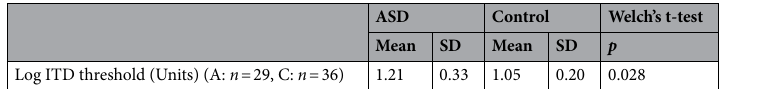
Table 4. Means, SDs, and p -values related to Welch’s t-test for the log-transformed ITD thresholds (outliers excluded).